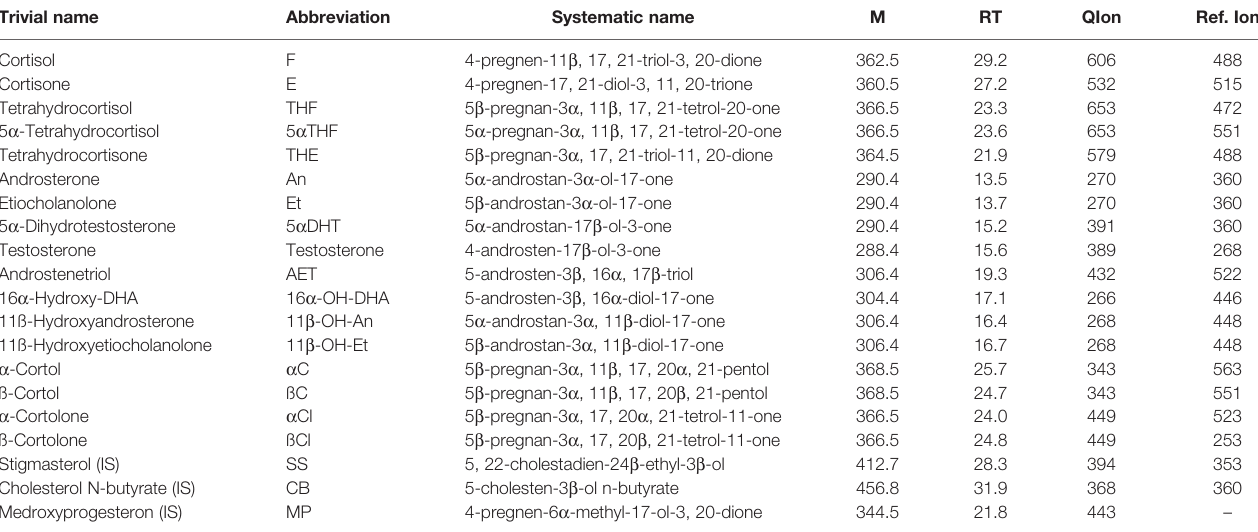
TABLE 2 | List of steroid compounds measured in